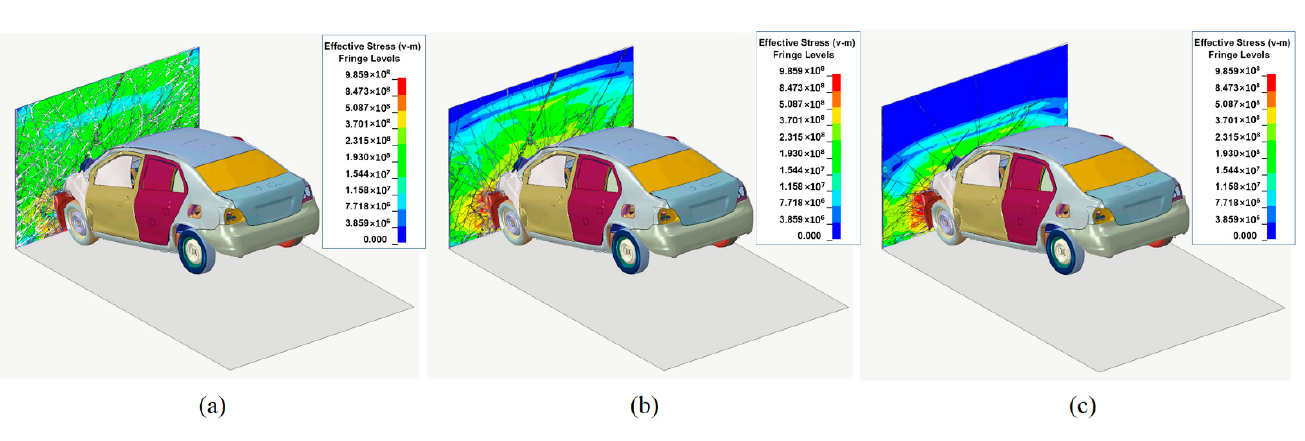
Figure 10. Results of the destruction of the VSG wall with PVB spacers: ( a ) sample #1 , 3 layers of VSG glass, single layer thickness: 20 mm + 2 PVB foil spacers with single spacer thickness of 2.28 mm, ( b ) sample #2 , 4 VSG glass layers, single layer thickness: 15 mm + 3 PVB foil spacers with single spacer thickness 2.28 mm, ( c ) sample #3 , 5 VSG glass layers with single layer thickness: 12 mm + 4 PVB foil spacers with single spacer thickness 2.28 mm.